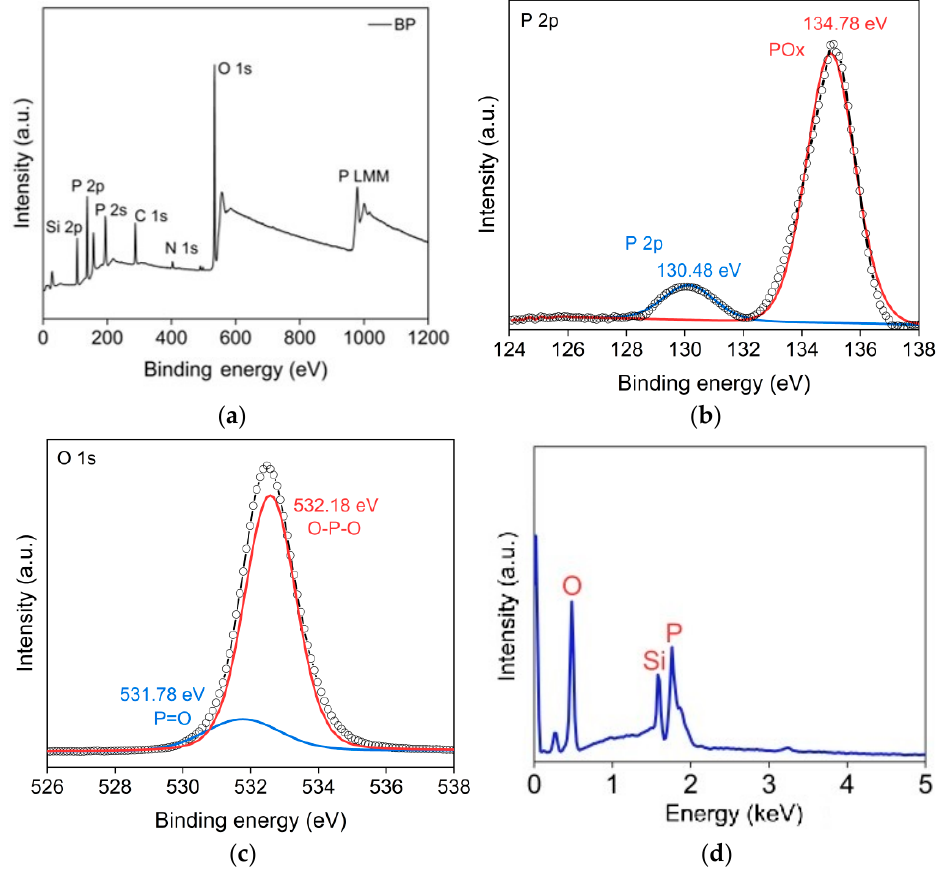
Figure 4. Compositional properties of BP QDs: ( a ) XPS survey spectrum; ( b ) XPS P 2p spectrum; ( c ) XPS O 1s spectrum; ( d ) EDS spectrum.